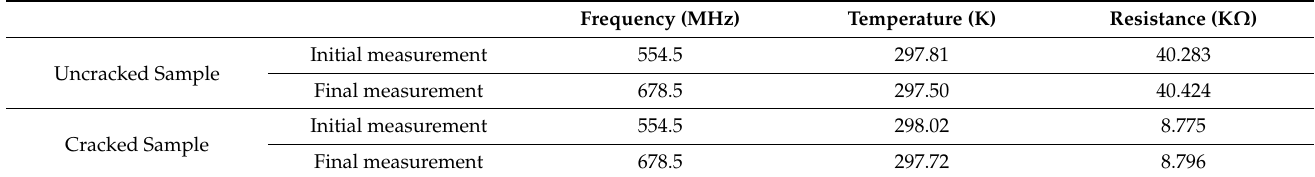
Table 1. Measured temperature and resistance in terms of the frequency for uncracked and cracked SWCNT composite films.